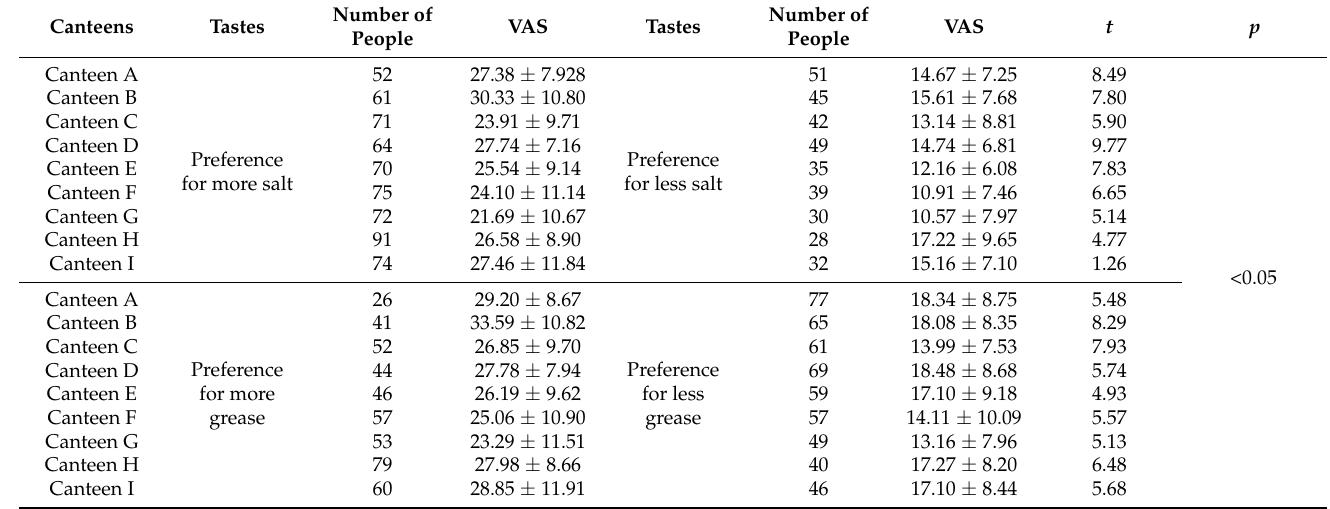
Table 6. Difference analysis of Visual Analogue Scale (VAS) scores of consumers by taste preference